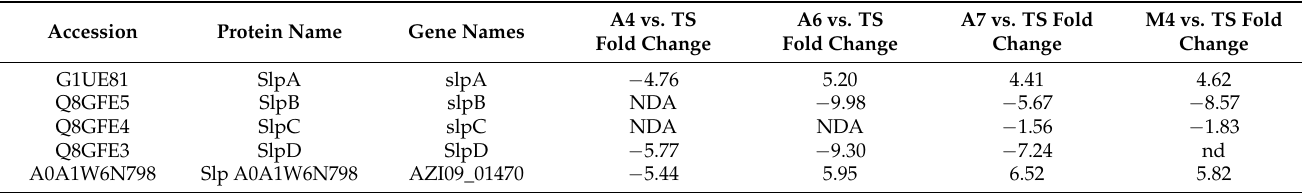
Table 3. Label free quantitative proteomic analysis of the main identified Slps in the five L. brevis